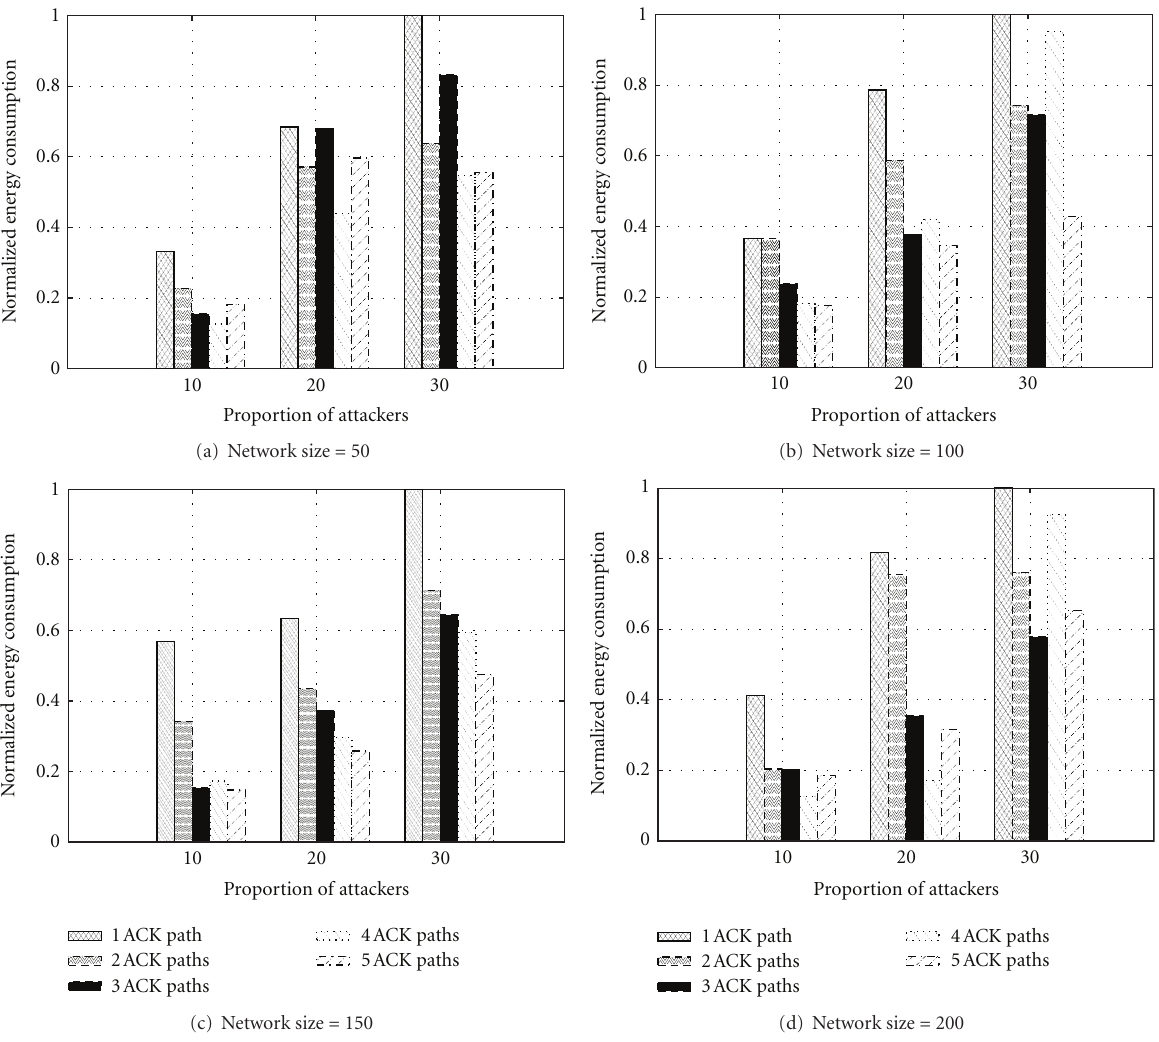
Figure 7: Extra energy consumption ∗ when network coding is confronting with flooding attackers ∗ when ACK is intercepted, the source node still sends encoded packets. The sending and receiving of these packets cause extra energy consumption. ∗ Refers to all figures presesnted in this